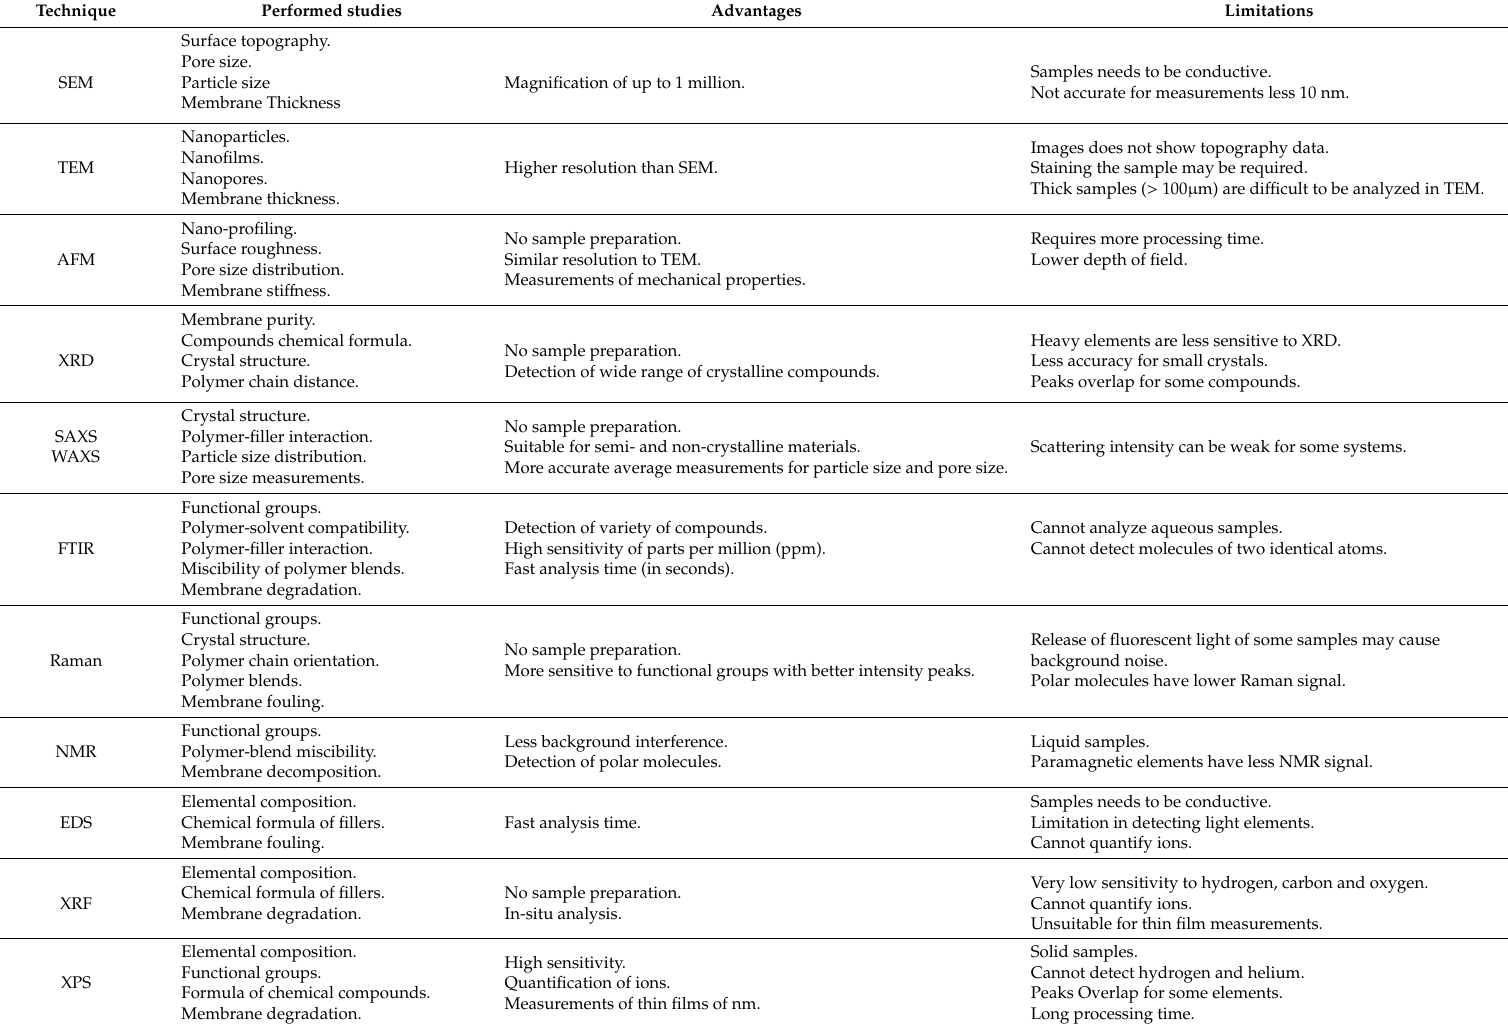
Table 13. Comparison of various characterization techniques for analysis of polymeric membranes. Technique Advantages